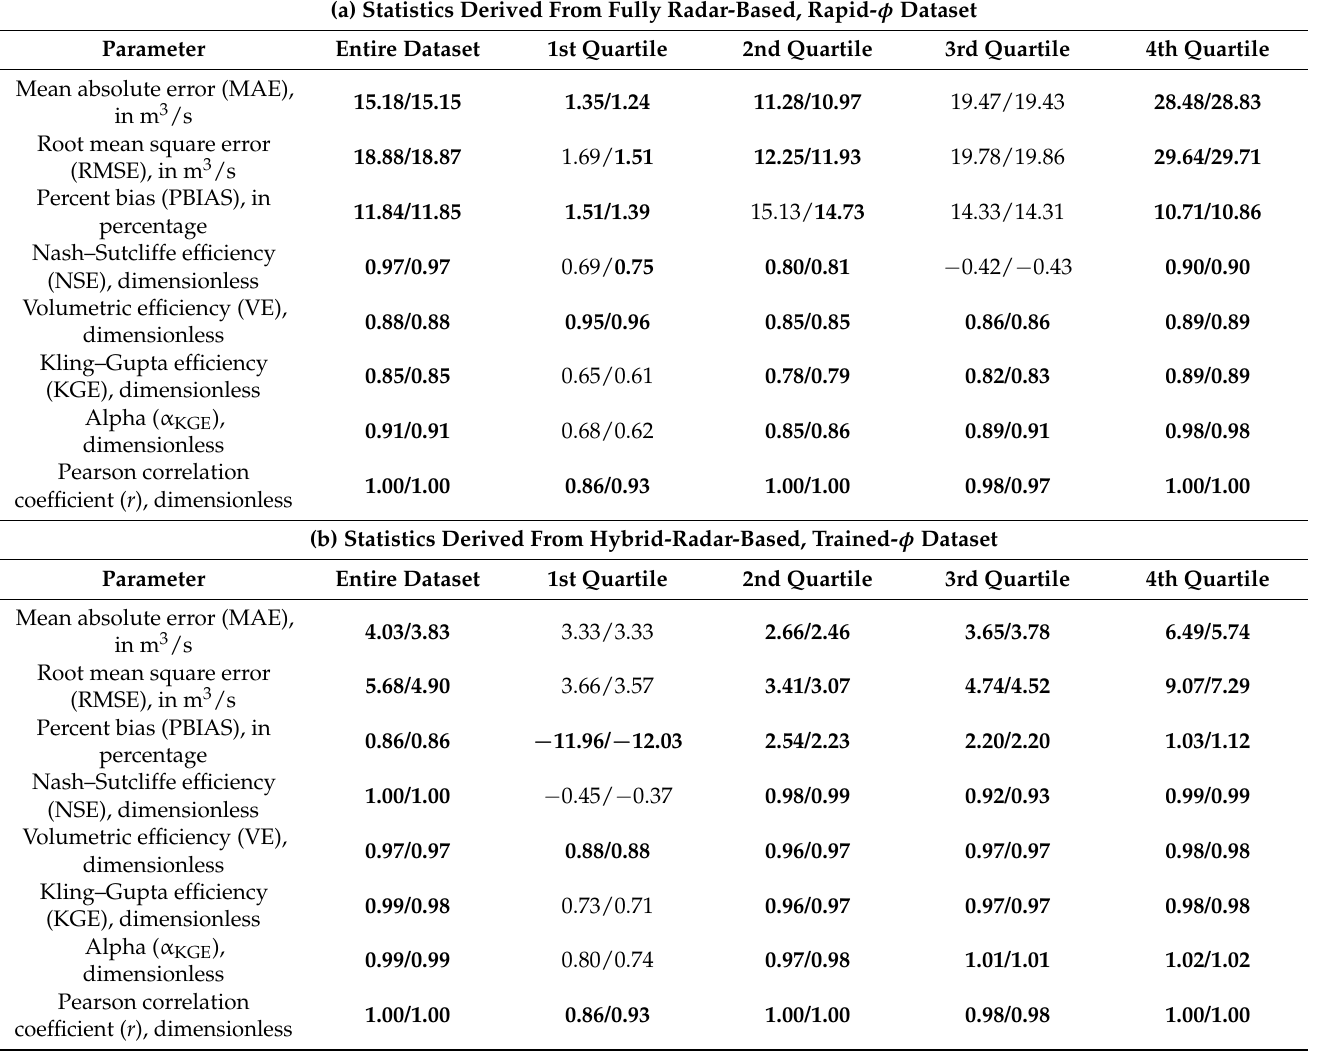
Table 4. Goodness-of-fit statistics associated with radar-based and USGS-streamgage-based discharge measurements, values in bold indicate they meet this study’s criteria for satisfactory performance defined in Section 2.3.2. ( a ) contains statistics from the fully radar-based, rapid- φ dataset in the format unfiltered (raw) data/LOESS-filtered data, and ( b ) contains statistics from the hybrid-radar-based, trained- φ dataset in the format unfiltered (raw) data/LOESS-filtered